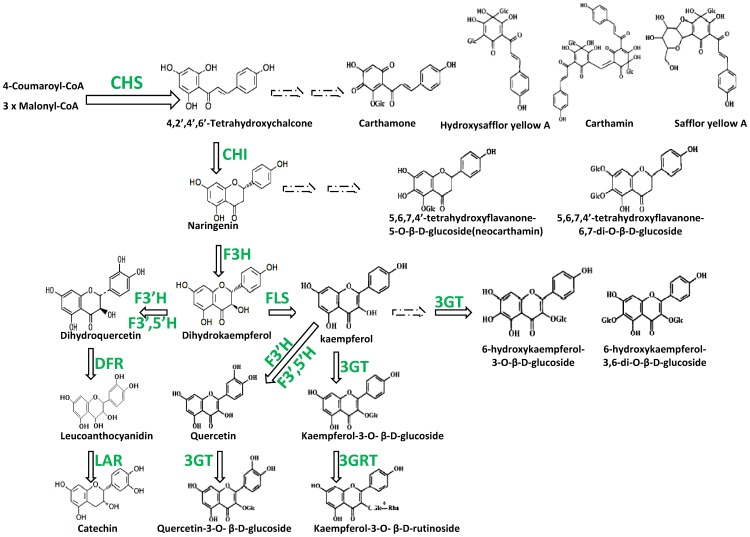
Predicted flavonoid biosynthetic pathway-related genes and products in the safflower flower.The pathways leading to the biosynthesis of different flavonoids. Abbreviations: CHS, chalcone synthase; CHI, chalcone isomerase; F3H, flavanone3-hydroxylase; F3′H, flavonoid 3′-hydroxylase;F3′5′H, flavonoid 3′,5′-hydroxylase; FLS, flavonol synthase; DFR, dihydroflavonol 4-reductase; LAR, leucoanthocyanidin reductase; 3GT, flavonol 3-O-glucosyltransferase; and 3GRT, flavonol-3-O-glucoside L-rhamnosyltransferase. The dotted arrow indicates that the involved enzymes are not yet clear.